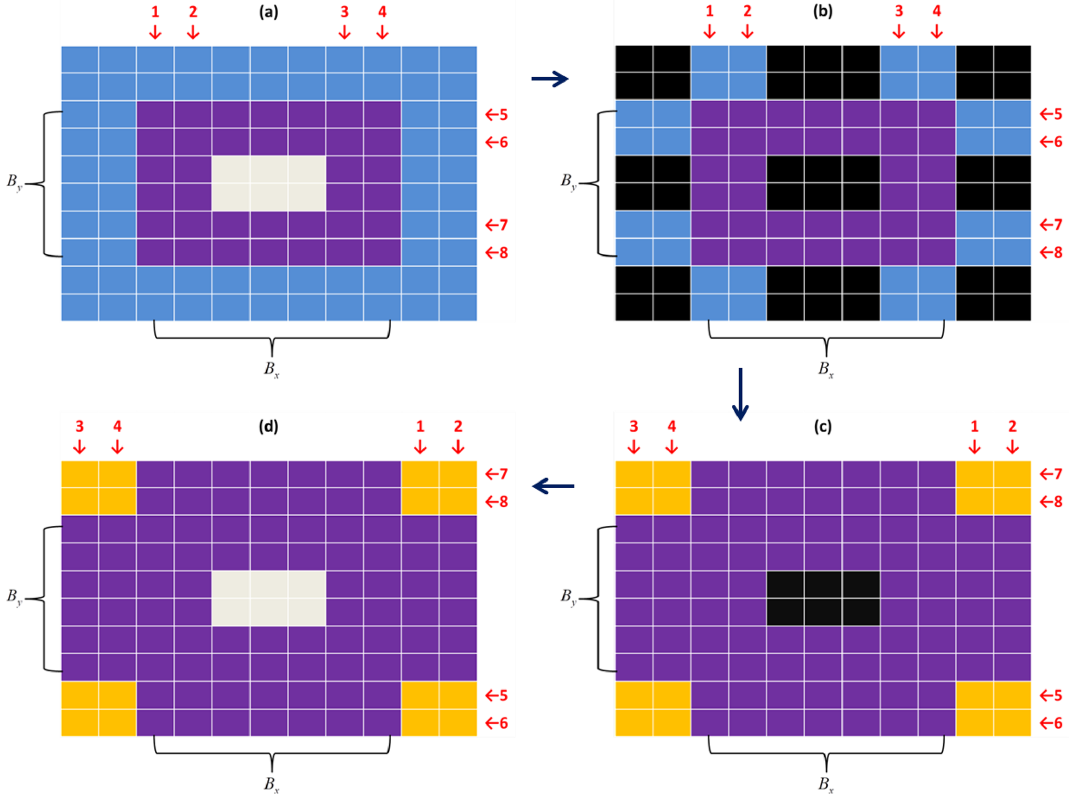
Figure 7. The lateral packing (only transferring four rows and four columns of data between the GPU and CPU) method to accelerate the halo. (a) In the GPU space, where central (gray) grids are unchanged; (b) transferred to the CPU space, where black grids mean no data; (c) after halo with neighbors; and (d) transfer back to the GPU